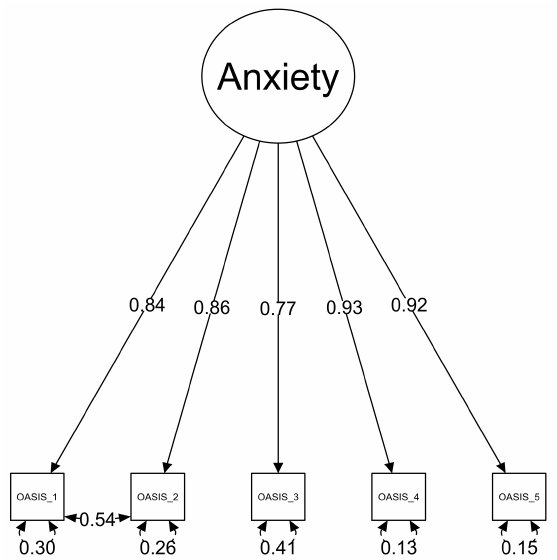
Figure 1. Factor loadings and residuals of the individual items of the OASIS, with correlated error terms between item 1 and 2 (Sample 2, n = 1015).